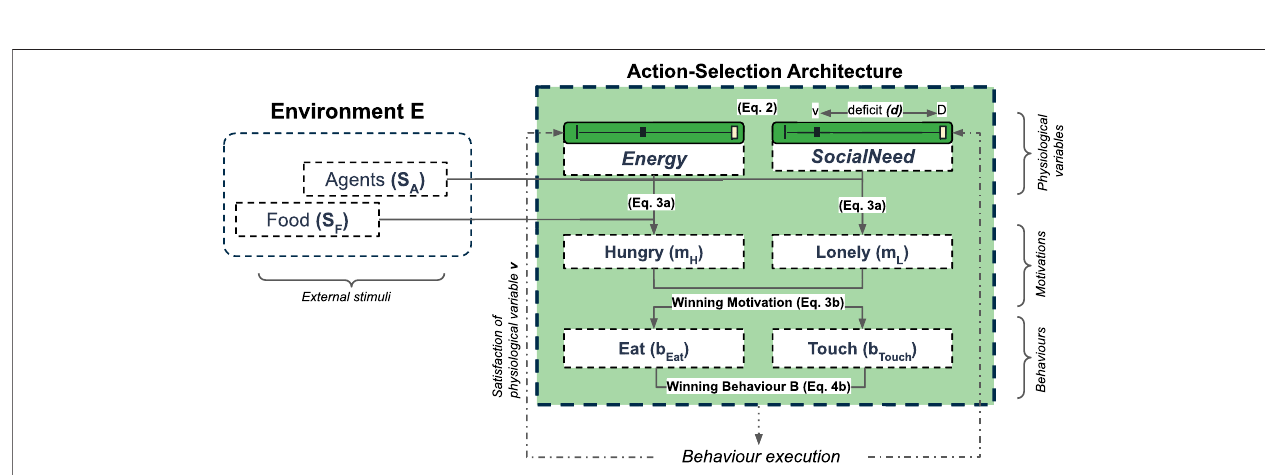
TABLE1| Relationshipbetweeninternal “ physiological ” variables v ,itsrelevantinternalmotivation m ,theexternalstimuli S relevanttoeachinternalvariable,andbehaviour b associated with each motivation OT: Oxytocin. CT: Cortisol. *: Only for agents with affective social bonds. **: Opposing effects based on behaviour: CT decreases (-) if Groom ; CT increases (+) if Aggression . TactInt (Tactile Intensity) and Speed t are discussed in the Agent Model section. All parameter values are apriori values taken from previous investigations (Khan et al., 2020; Khan and Cañamero, 2021). Internal variable